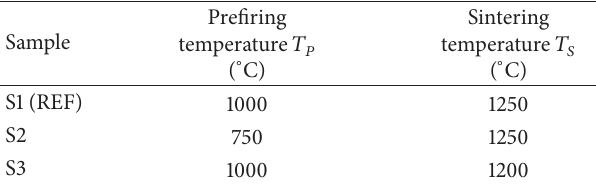
Table 1: Experimental variables under test.